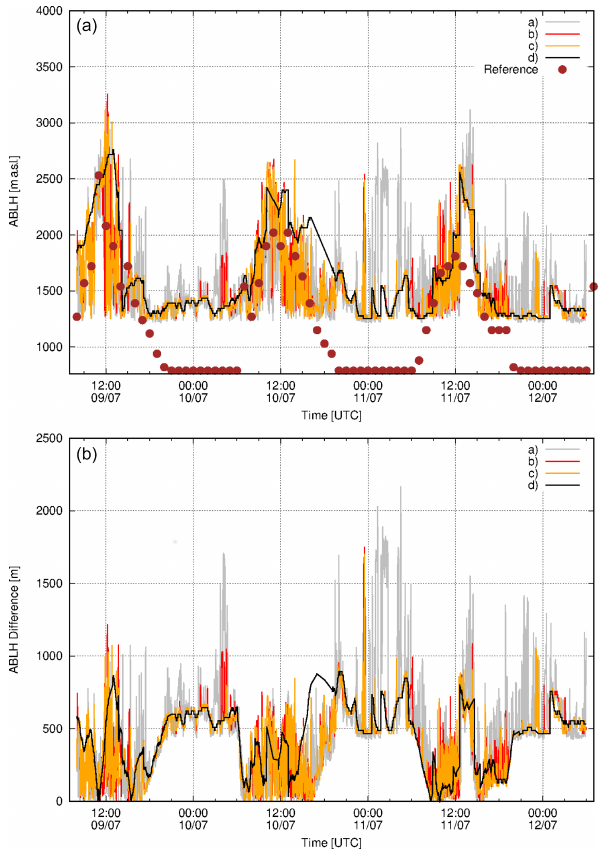
Figure 3. (a) ABLH retrieved during the 72h EARLINET exer- cise (9–12 July 2012) for Potenza. Gray, red, yellow and black lines show the ABLH retrieved from 1064nm high-resolution total atten- uated backscatter time series by applying the edge detector module on full-resolution data (curve a ), the vertical resolution reduction module and the edge detector (curve b ), the vertical resolution re- duction module, the pre-processing module and the edge detector (curve c ) and the whole MIPA procedure (curve d ). Brown circles are the reference ABLHs as retrieved from atmospheric temperature and pressure profiles provided by ECMWF forecasts. (b) Absolute differences of the retrieved ABLHs with respect to the reference. The original time resolution of ECMWF forecasts is 1h. They have been interpolated at the lidar data time resolution